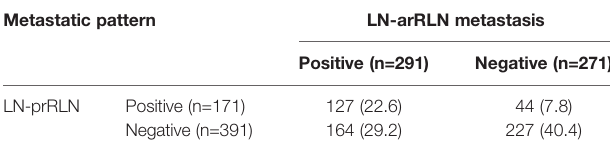
TABLE 2 | Pattern of the right central lymph node metastasis in 562